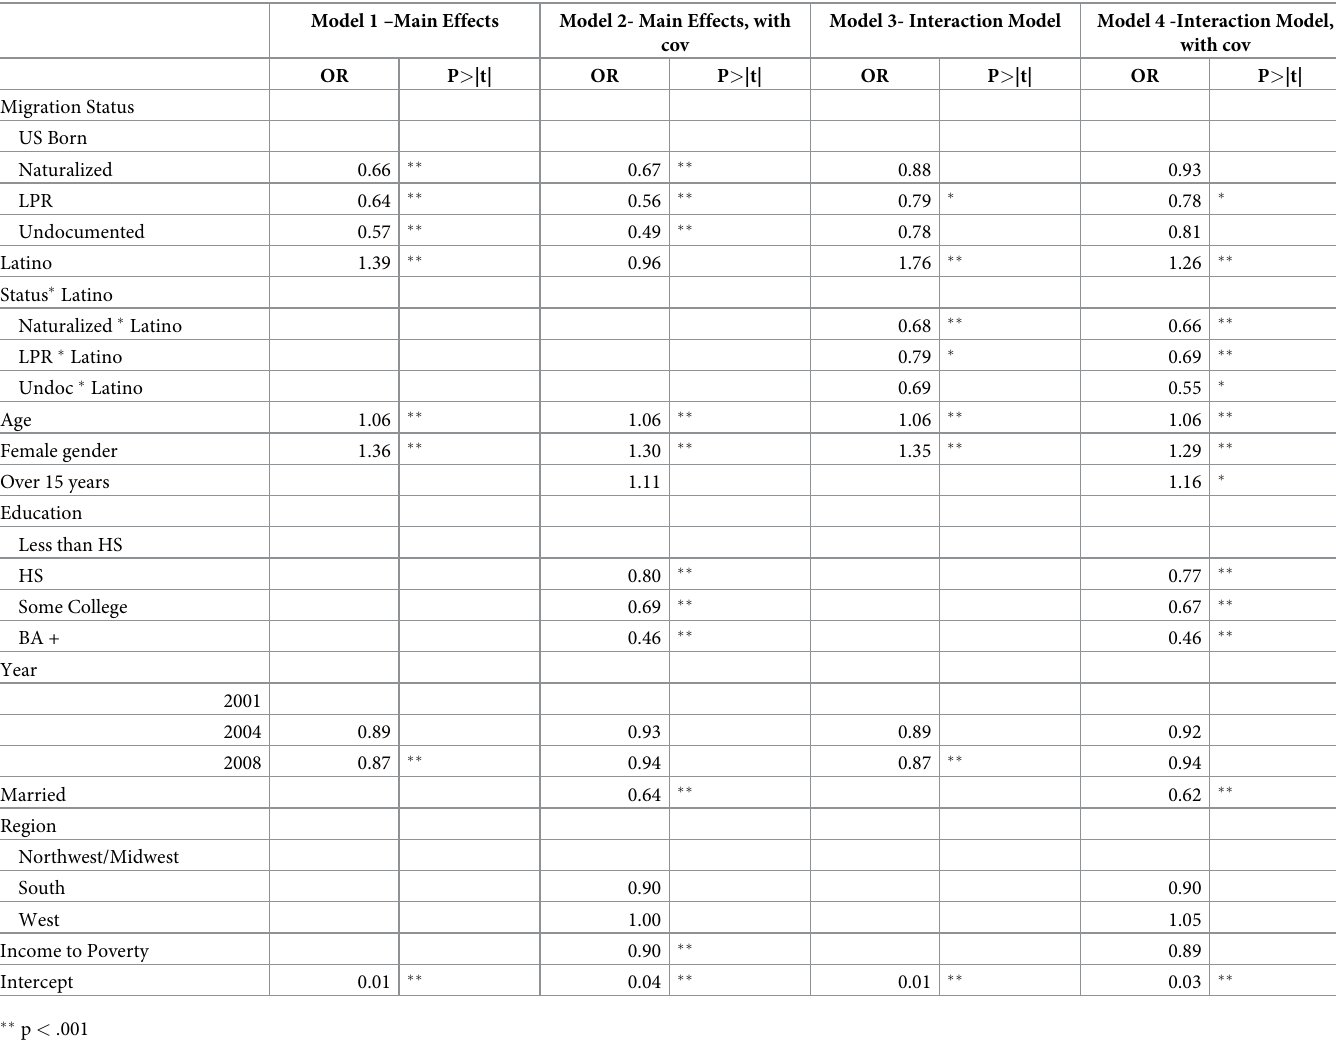
Table 3. Logistic regression for immigration status and functional disability, main effects and interaction between race/ethnicity, 2001/2004/2008